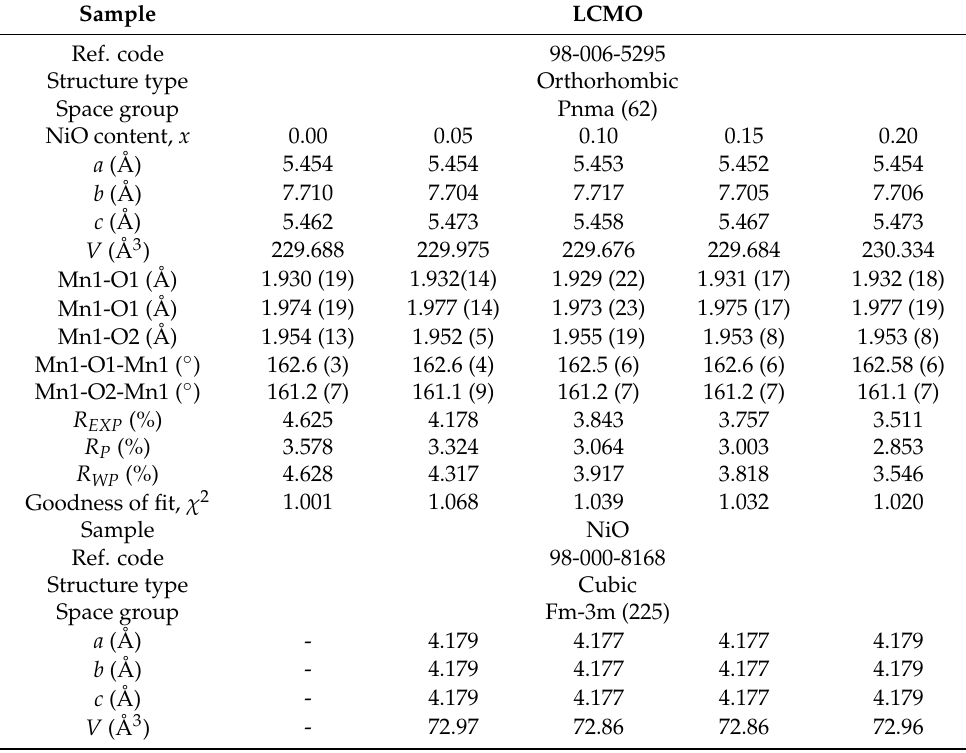
Figure 1. ( a ) XRD patterns of LCMO:NiO composites. ( b ) Rietveld refinement of LCMO. Table 1. Rietveld refinement data of pure LCMO and LCMO:NiO composites. Table 2. The D , T MI , and MR (%) at 80 K for sample x = 0.00, 0.05, 0.10, 0.15 and 0.20.